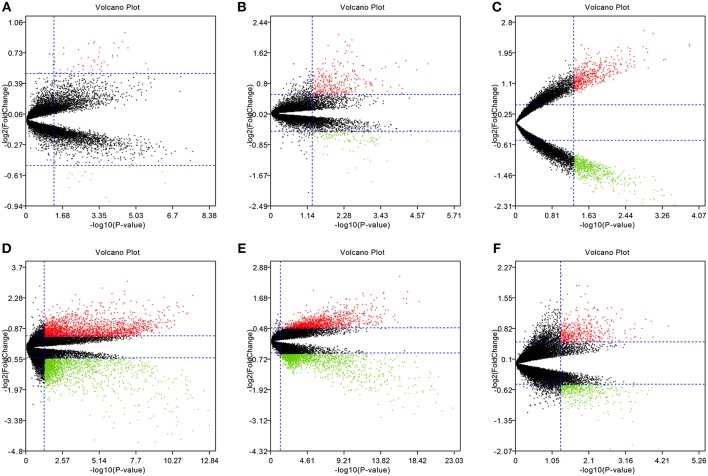
Volcano plots of the six microarrays. Red points represented up-regulated genes, while green points represented down-regulated genes. Black points represented genes with no significant difference. (A) GSE48452, (B) GSE63067, (C) GSE66676, (D) GSE72756, (E) GSE89632, (F) GSE107231.